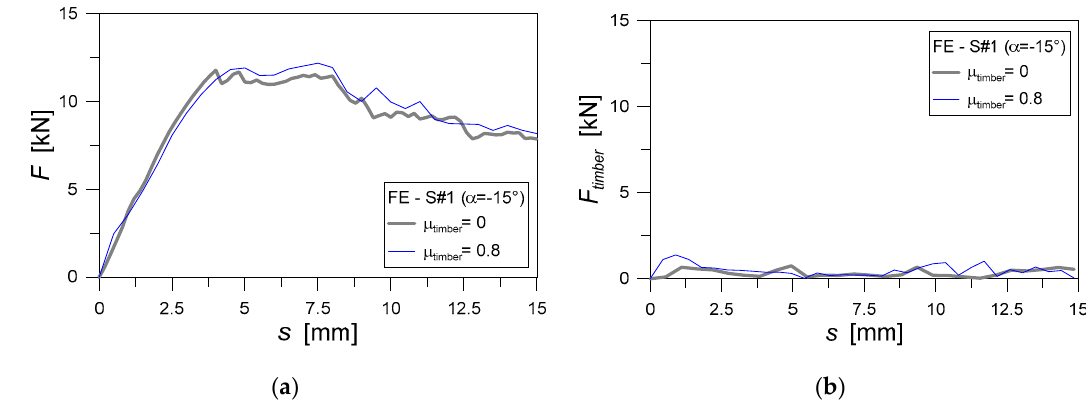
Figure 19. Analysis of static friction effects on the PO numerical response of TTC joints with inclined STSs. In evidence, the ( a ) vertical and ( b ) horizontal base reaction force, as a function of the measured slip (ABAQUS/Explicit).